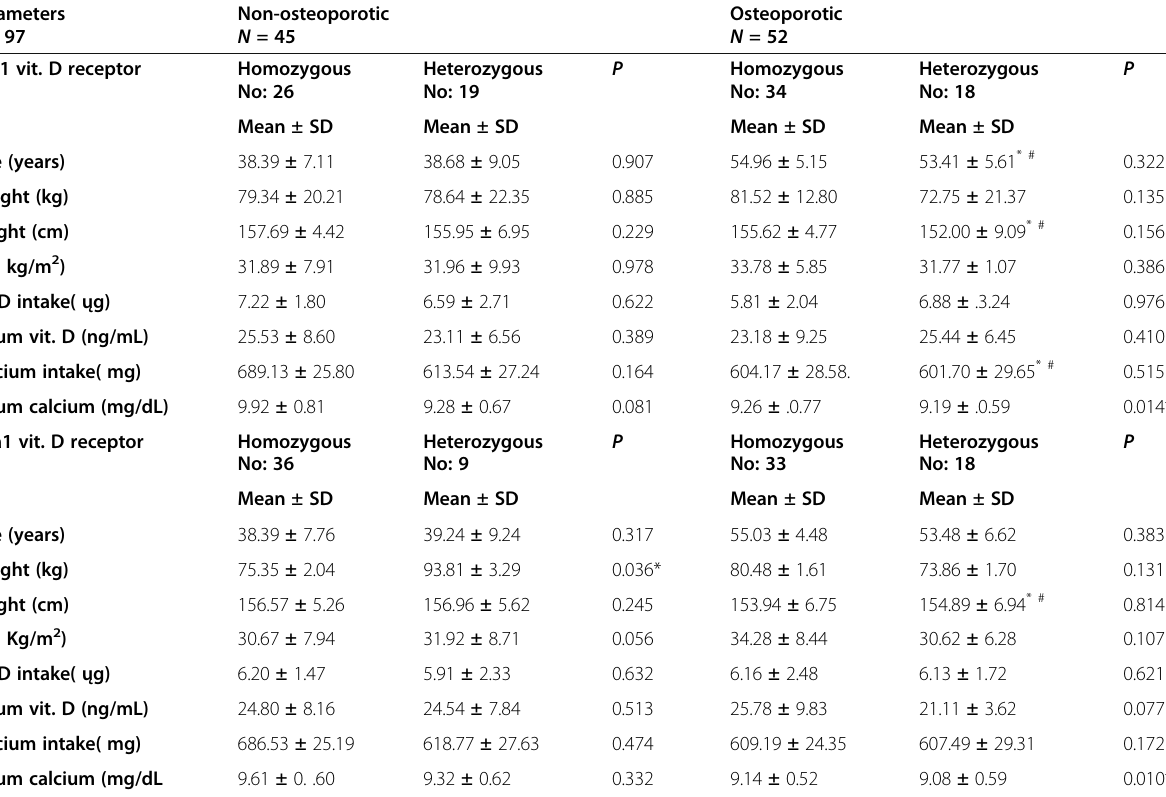
Table 2 Comparison between different studied vitamin D receptors genes genotypes regarding the related investigated parameters Parameters N = 97